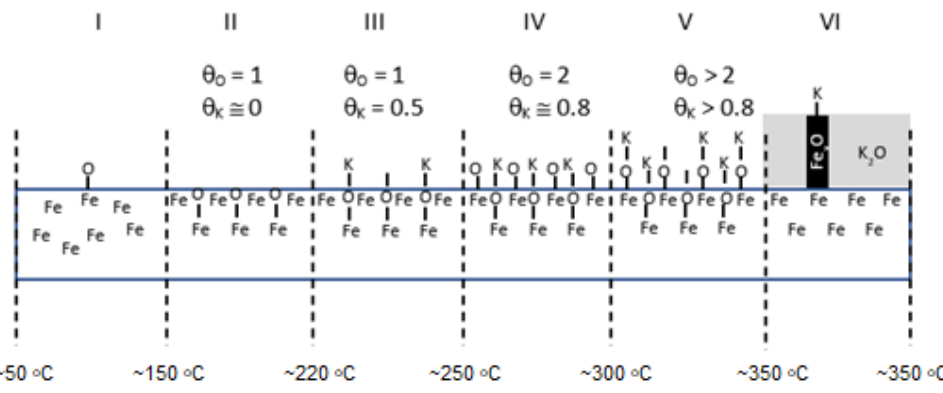
Figure 4. Schematic picture of surface structure of the Fe-K sample.